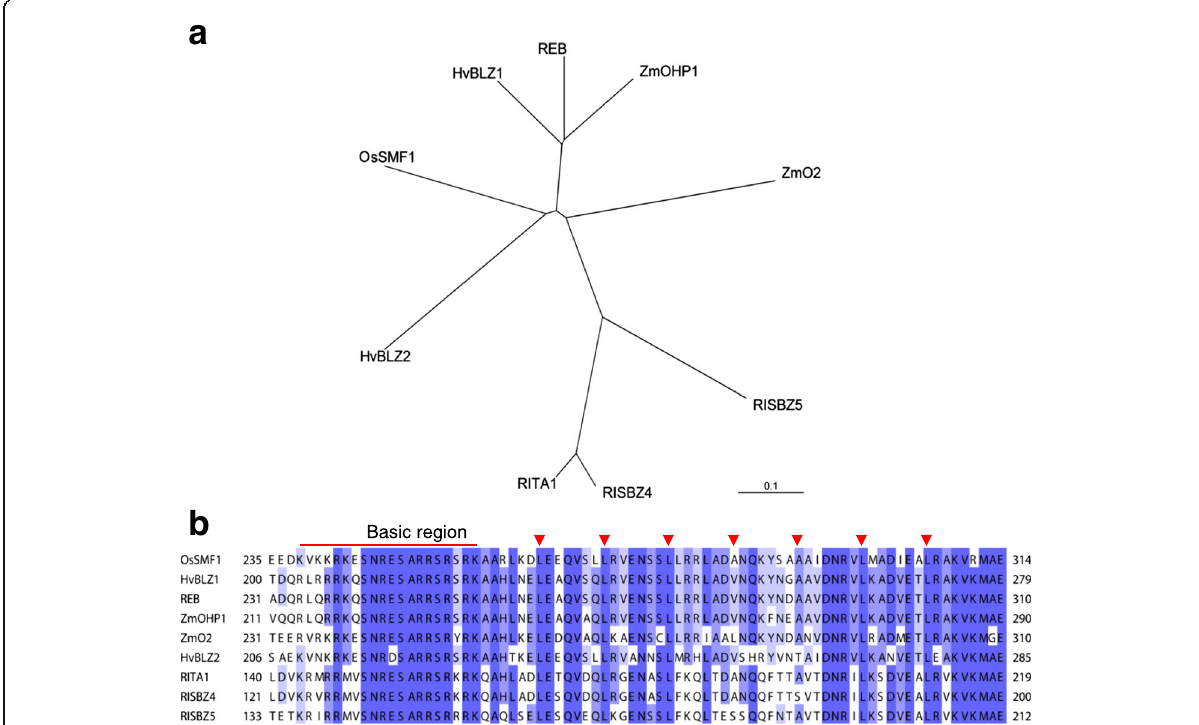
Fig. 1 Phylogenetic and amino acid comparisons of bZIP transcription factors. a Phylogenetic tree of bZIP transcription factors from Oryza sativa (OsSMF1: LOC_Os07g08420, REB: LOC_Os03g58250, RITA1: LOC_Os02g16680, RISBZ4: LOC_Os02g07840, and RISBZ5: LOC_Os06g45140), Zea mays (ZmO2: CAA34614 and ZmOHP1: EF144174), and Hordeum vulgare (HvBLZ1: CAA56374 and HvBLZ2: CAA71795). The phylogenetic tree was constructed using Clustal Omega (http://www.ebi.ac.uk/Tools/msa/clustalo/) with full-length sequences, including transit peptides, and it was visualized